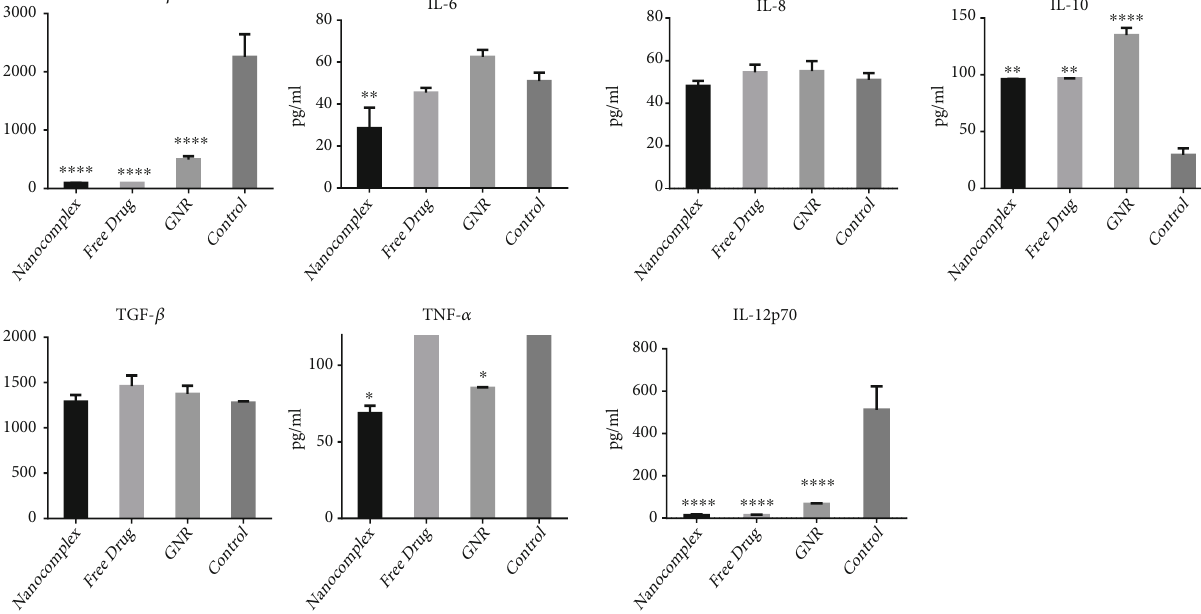
Figure 4: Measurement of the expression level of cytokines secreted by macrophages treated with the following: nanocomplex (a drug- conjugated gold nanorods), the free drug (phosphatidylinositol 3-kinase (PI3K α ) inhibitor) and GNR; cholesterol-coated gold nanorods and compared to the control untreated cells by using CBA array beads by fl ow